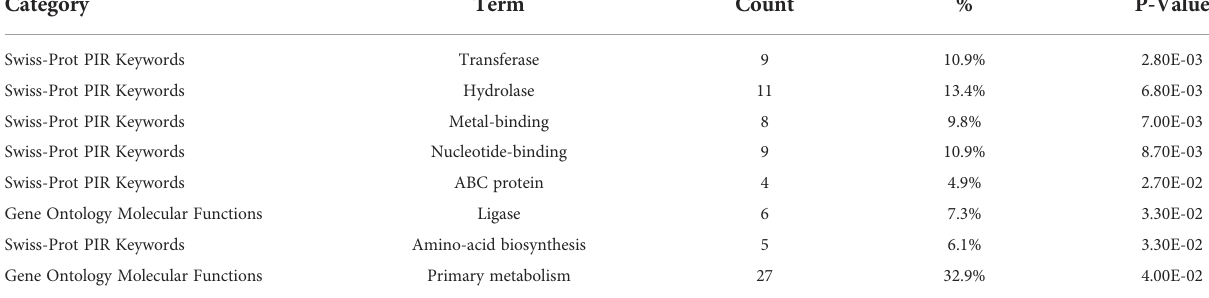
TABLE 4 Repressed functional categories.